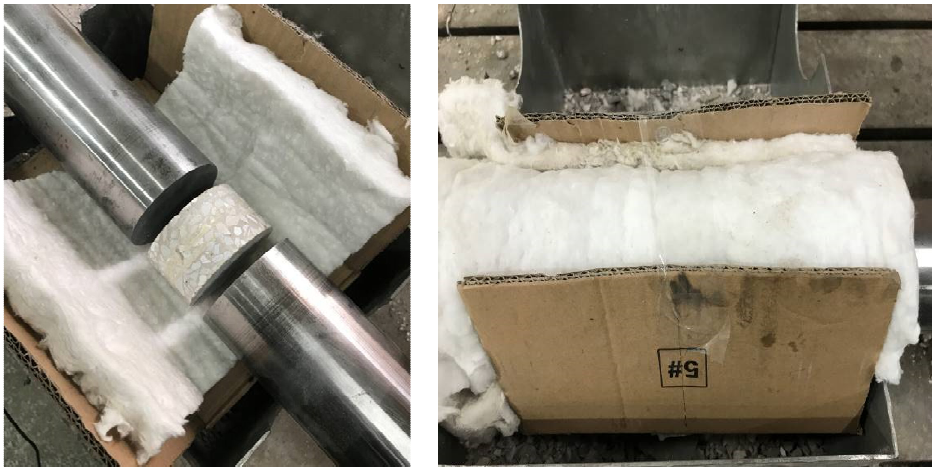
Figure 6. Insulation measures for the HPC during SHPB tests.